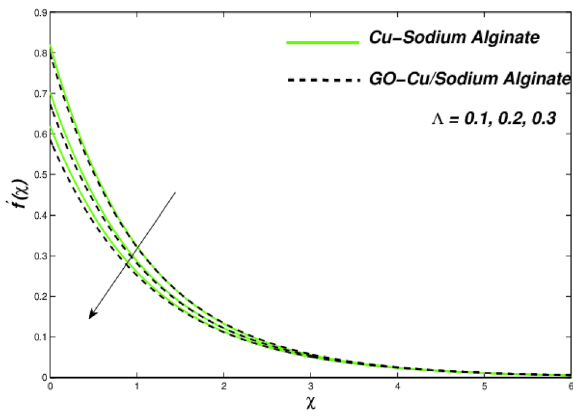
Figure 18. Velocity variations subject to (cid:31) .